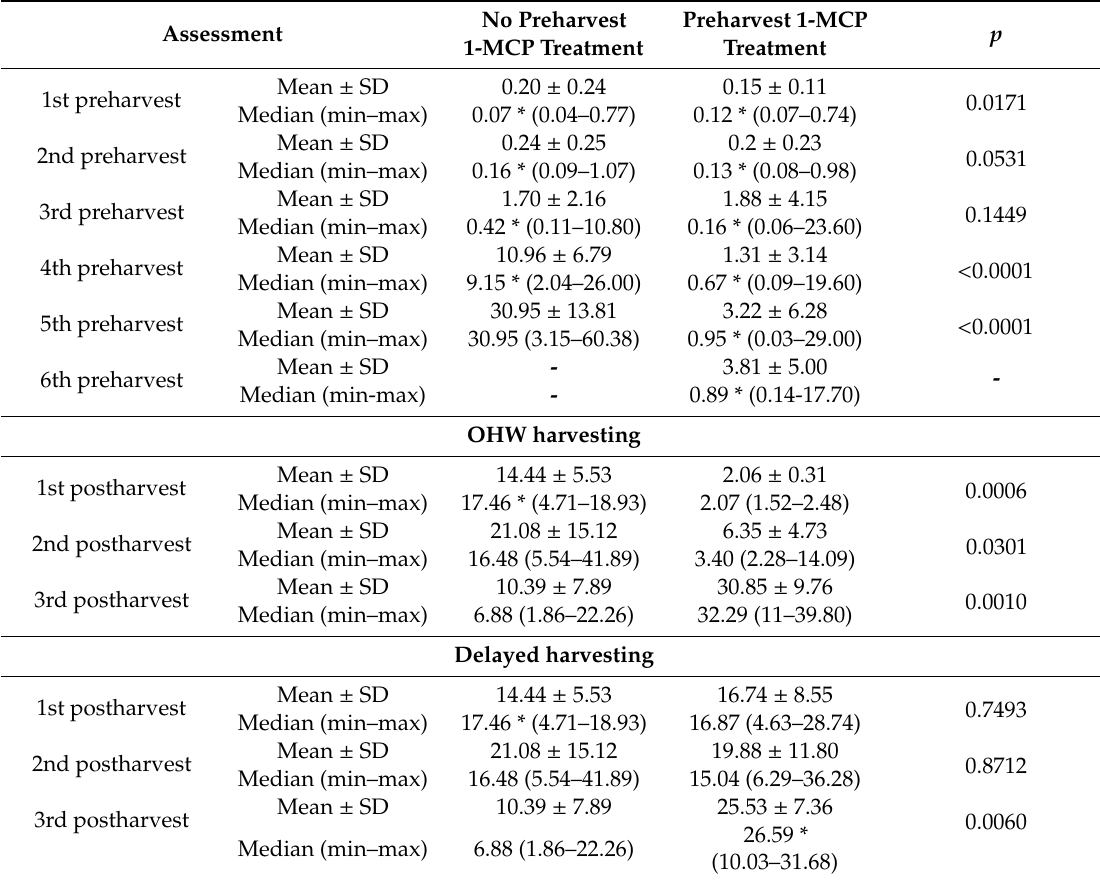
Table 1. Results for internal ethylene content ( µ l / l) measured in the core space for ‘Szampion’ cultivar apples in the pre- and postharvest periods, compared for groups treated with 1-MCP and a control group not treated with